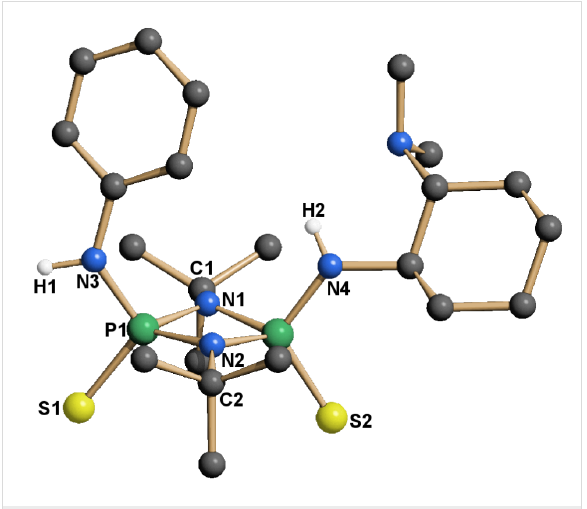
Figure 8: X-ray structure of 16 . The hydrogen atoms are omitted for clarity, except at nitrogen.